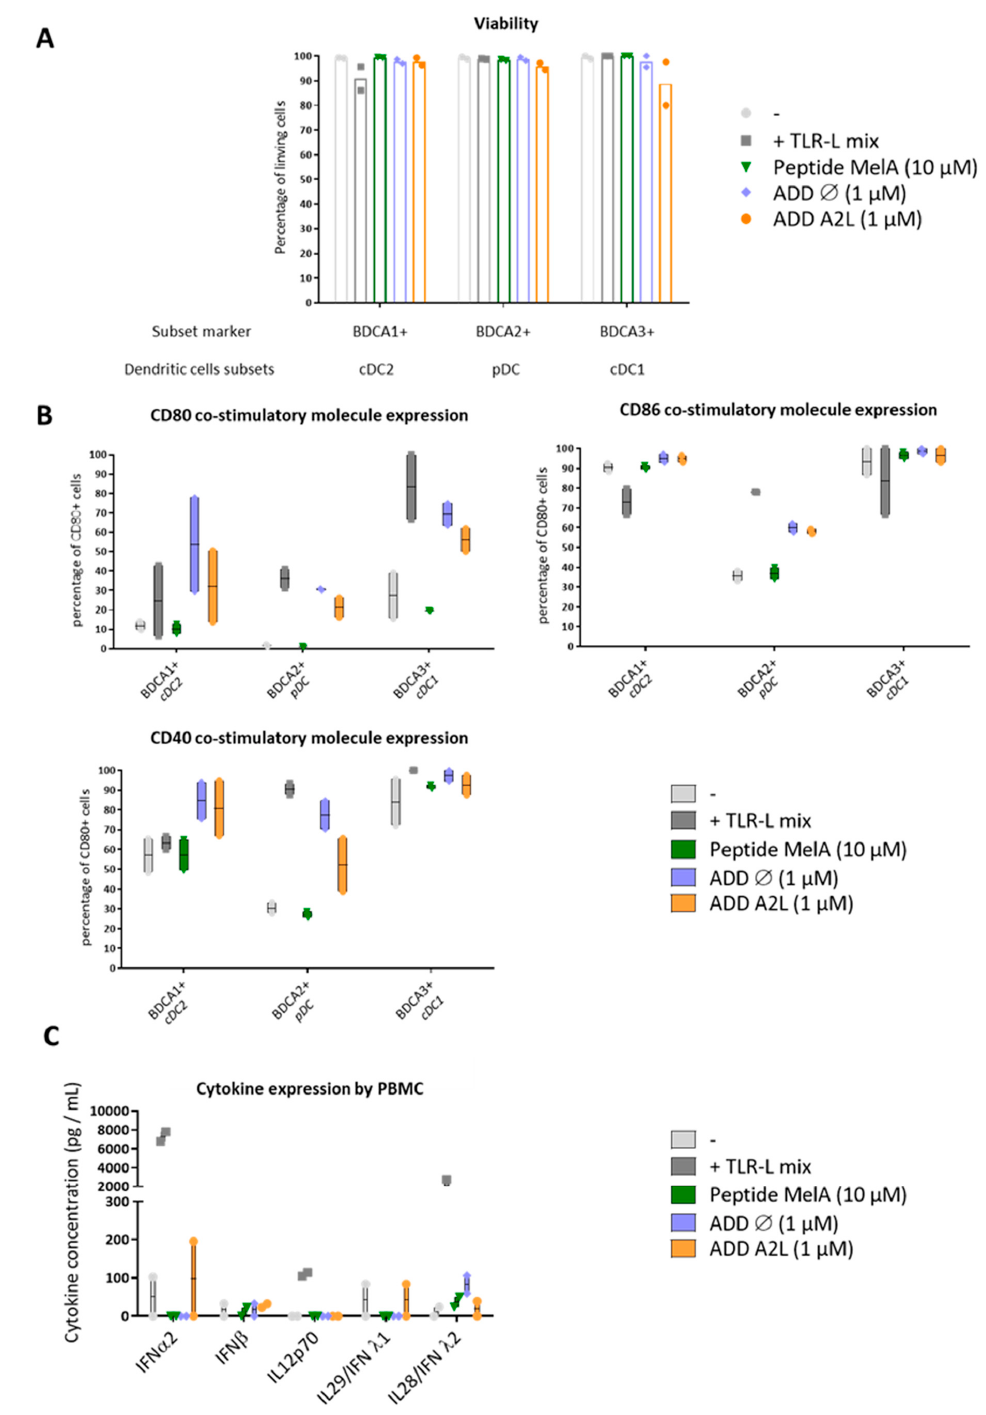
Figure 3. ADDomer triggers a strong activation of DC subsets together with cytokine secretion. PBMCs were cultured for 24 h in control conditions ( − ), or with either a mixture of TLR-L (Poly IC, R848, CpGA), MelA 26–35 peptide (10 µ M), empty ADDomer (ADD Ø) or displaying A2L (ADD A2L) both at 1 µ M. The viability, activation and cytokine secretion by DC subsets were then evaluated. ( A ) Impact of ADDomer on DCs’ viability assessed by measuring the percentage of alive cDC2s (BDCA1+), cDC1s (BDCA3+) and pDCs (BDCA2+) ( n = 2 donors). ( B ) Impact of ADDomer on DCs’ activation depicted by evaluating the percentage of CD40+, CD80+ and CD86+ DC subsets ( n = 2 donors). ( C ) Cytokine secretion measured in the culture supernatants by Luminex ( n = 2